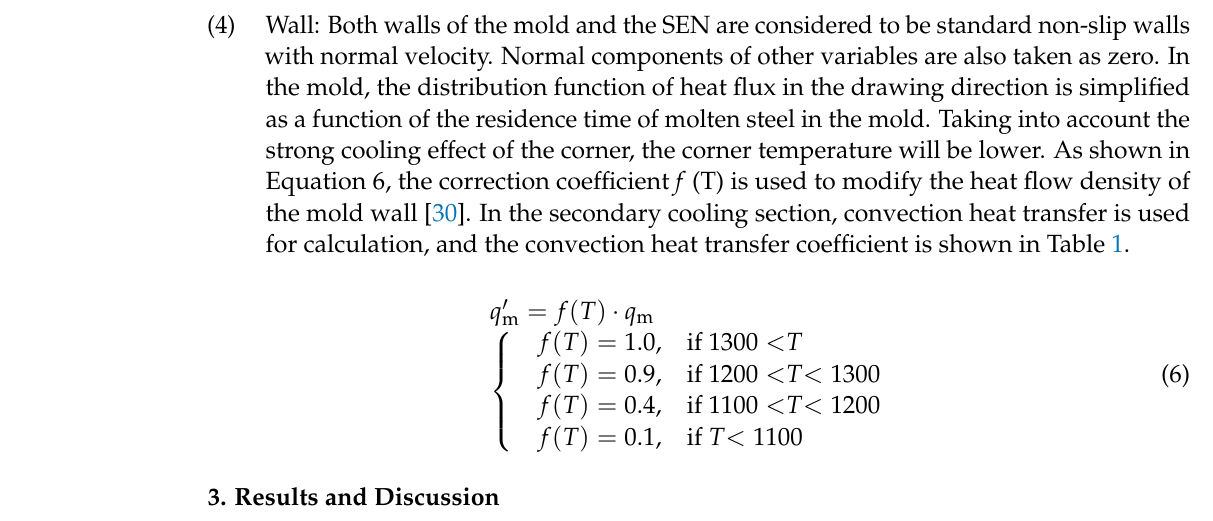
Figure 6. Three-dimensional distribution diagram of nonmetallic inclusions at different angles in the center sample of the slab. It can be seen from Figure 5 that there are obvious inclusion accumulation areas in the inner and outer arc sides of the slab edge sample (in the blue areas). The distribution of the number of inclusions is most obvious near 1/8~1/4 slab thickness regions of the inner arc side (in the red area), while a small number of inclusions are scattered in the remaining part of the sample. It can be seen from Figure 6 that only a few inclusions in the center sample of the slab are scattered, and the density is smaller than that of the sample at the edge of the slab. Additionally, there is no obvious accumulation of inclusions at 1/8~1/4 slab thickness re- gions of the inner arc side (in the orange area). The central sample of the slab has inclu- sions distributed at 1/8~1/4 slab thickness regions of the inner arc side dispersedly, and the number of inclusions is slightly more than the corresponding position of the outer arc side. The number of inclusions in the center sample of the slab as a whole is lower than that of the sample at the edge of the slab. As shown in the blue area in Figure 5, there are inclusions gathering areas on the inner and outer arc sides of the sample at the edge of the slab because the molten steel has